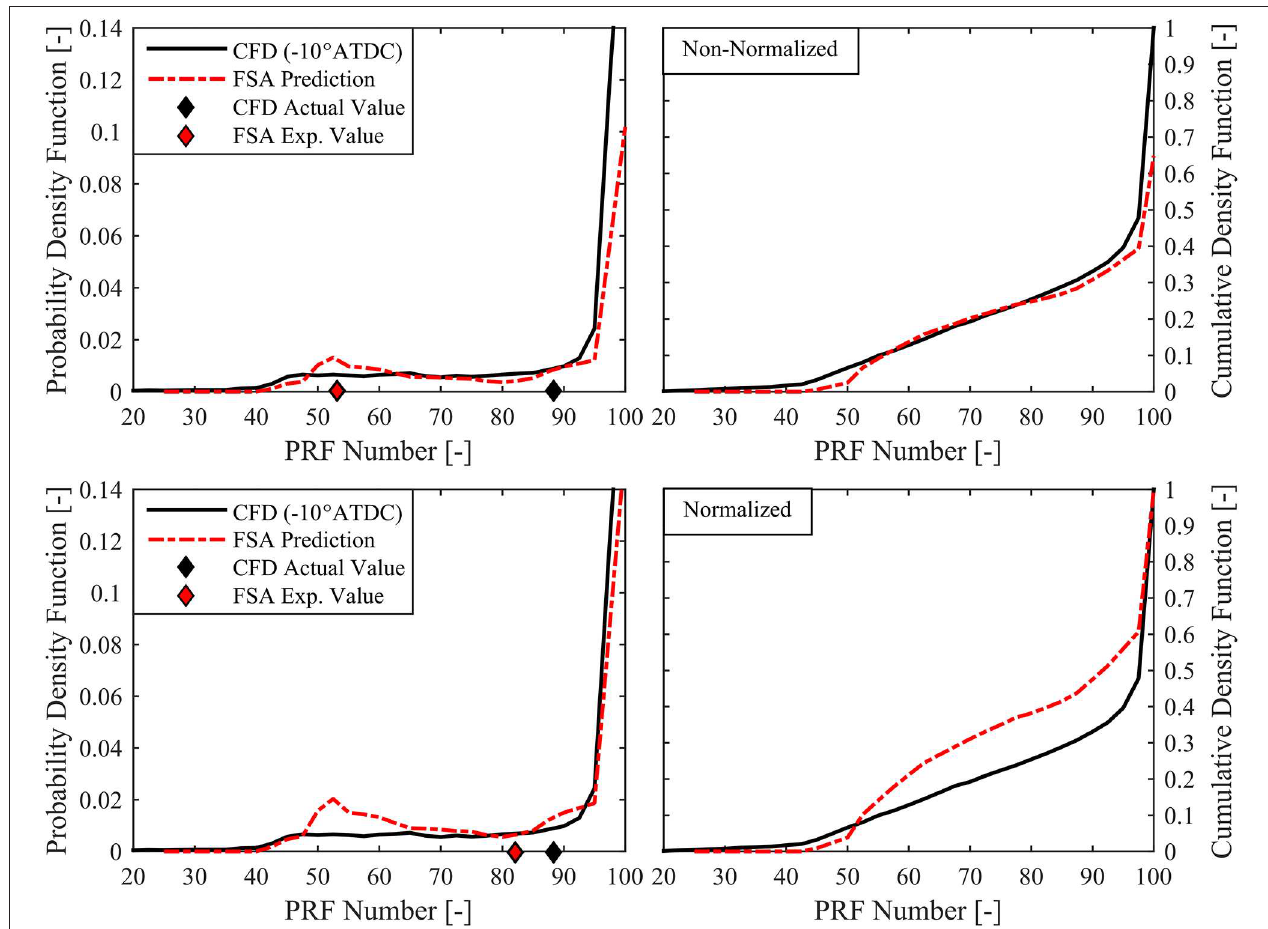
FIGURE 9 | PDF (Left) and CDF (Right) vs. PRF Number for non-reacting CFD at 0 ◦ CA for − 30 ◦ SOI case, compared to non-normalized FSA method result (Top) , and normalized FSA method result (Bottom)